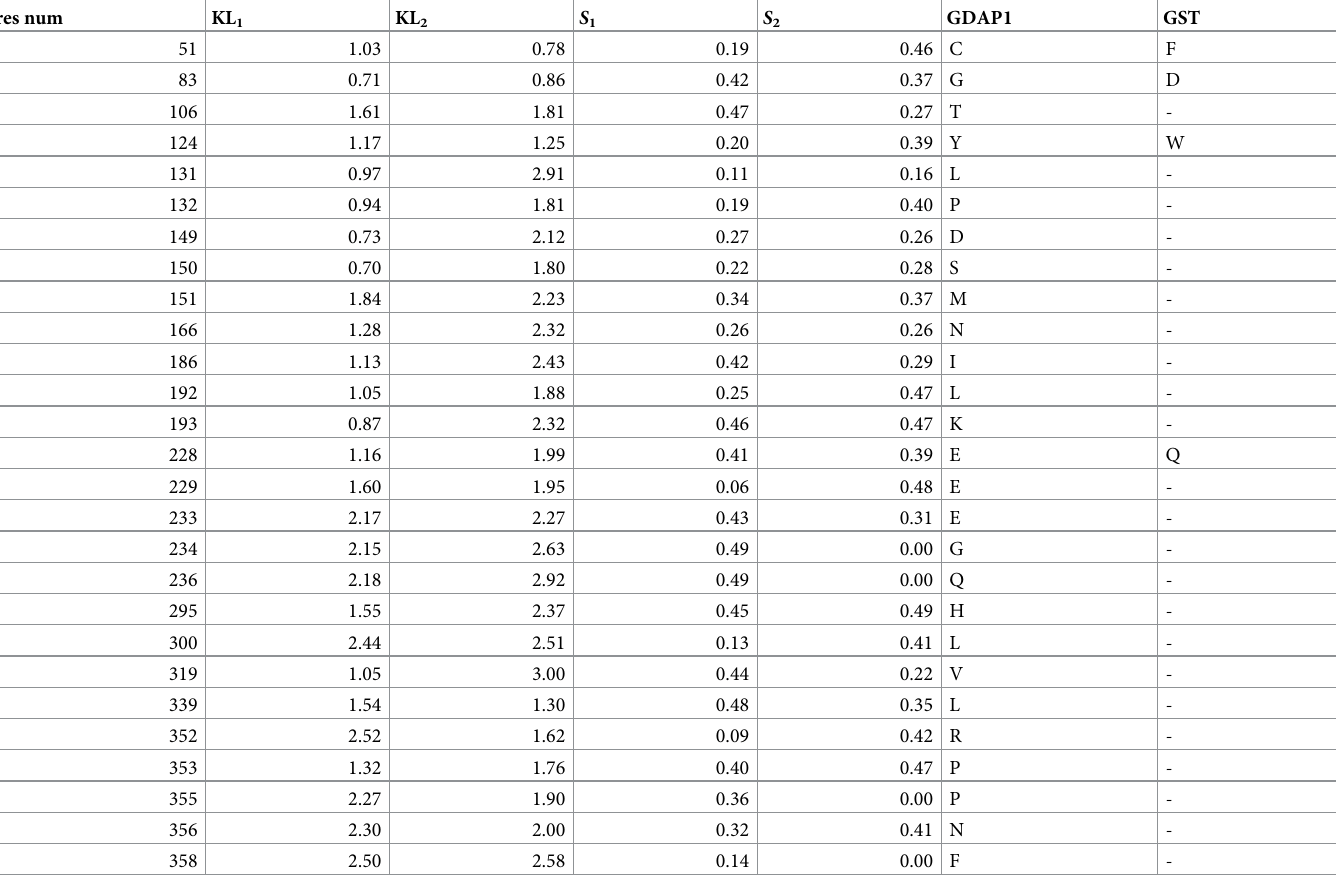
Table 6. KL divergence. KL 1 and KL 2 are the Kullback-Leibler divergence using the GDAP1 or GST group as reference distribution. S 1 and S 2 are the sequence entropy within the two groups. GDAP1 and GST show the most common residue within each